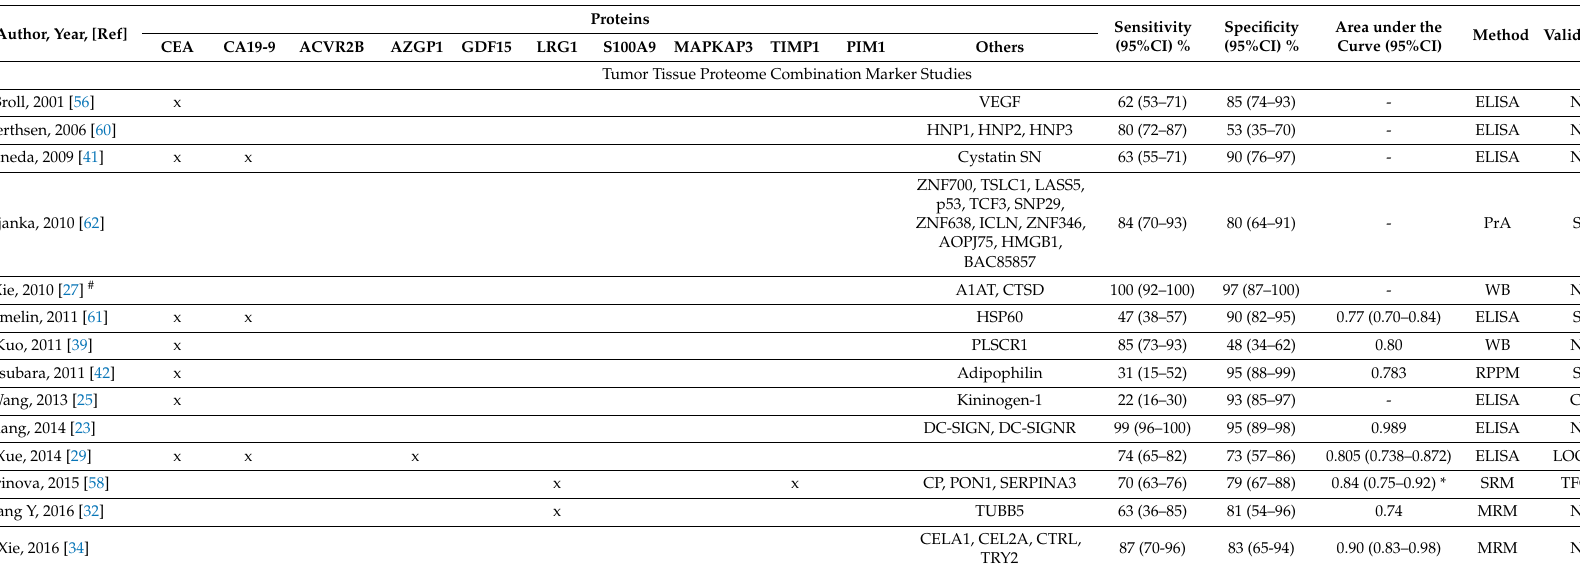
Table 4. Diagnostic performance of tumor tissue proteome/TIF markers validated in